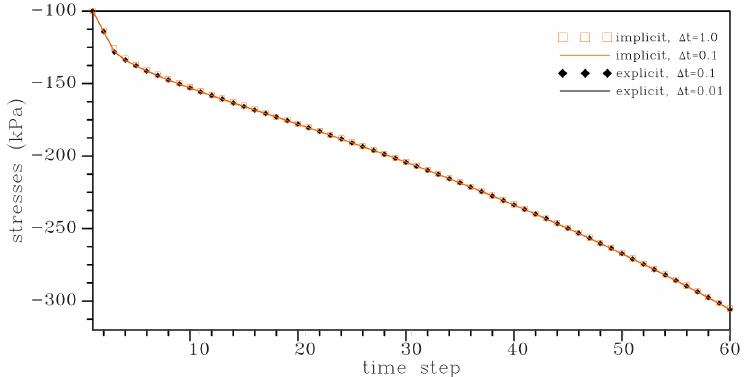
Figure 3. Test 1. Time evolution of the stress σ 11 at different time steps for explicit and implicit time integrations.